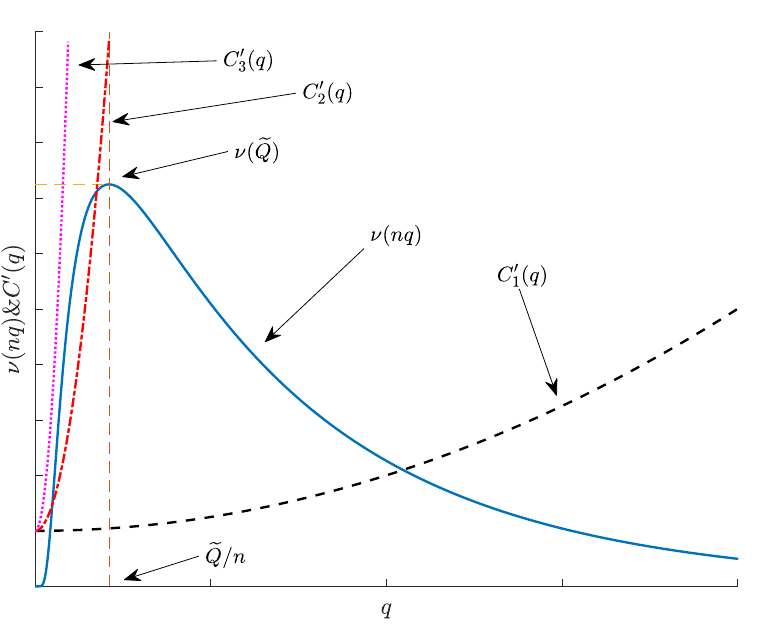
Figure 3. Information Acquisition When Λ (cid:54) =